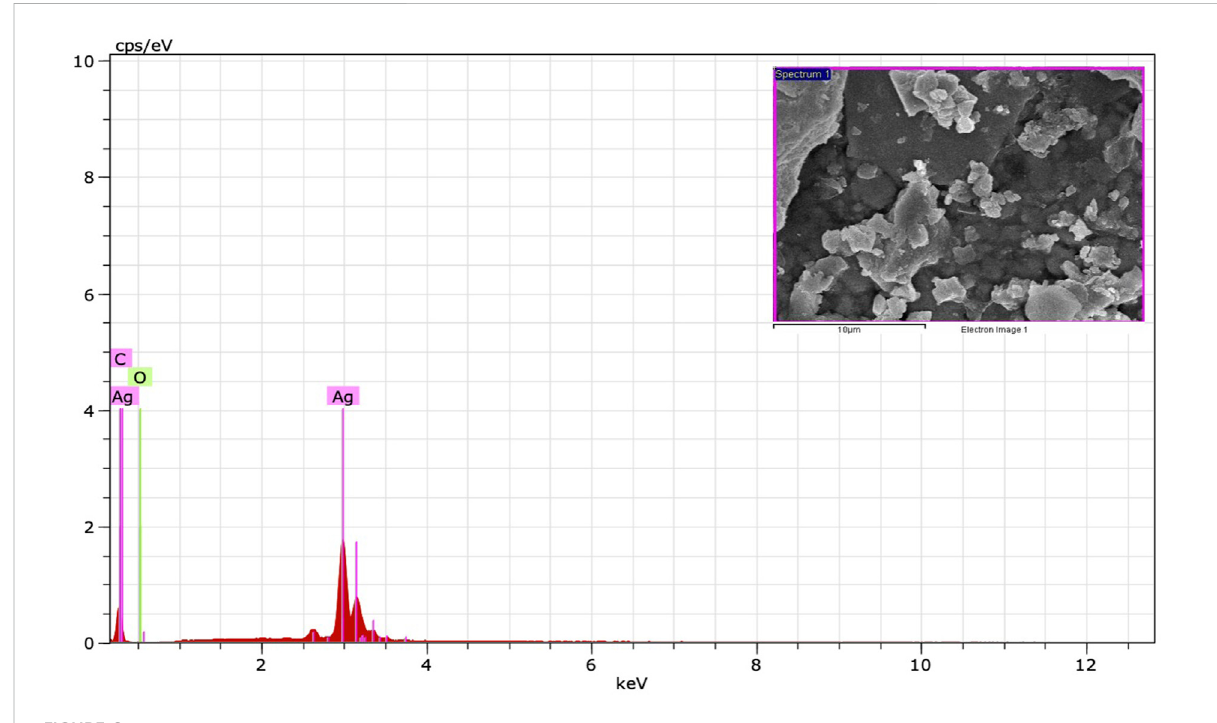
FIGURE 6 EDS spectrum of synthesized